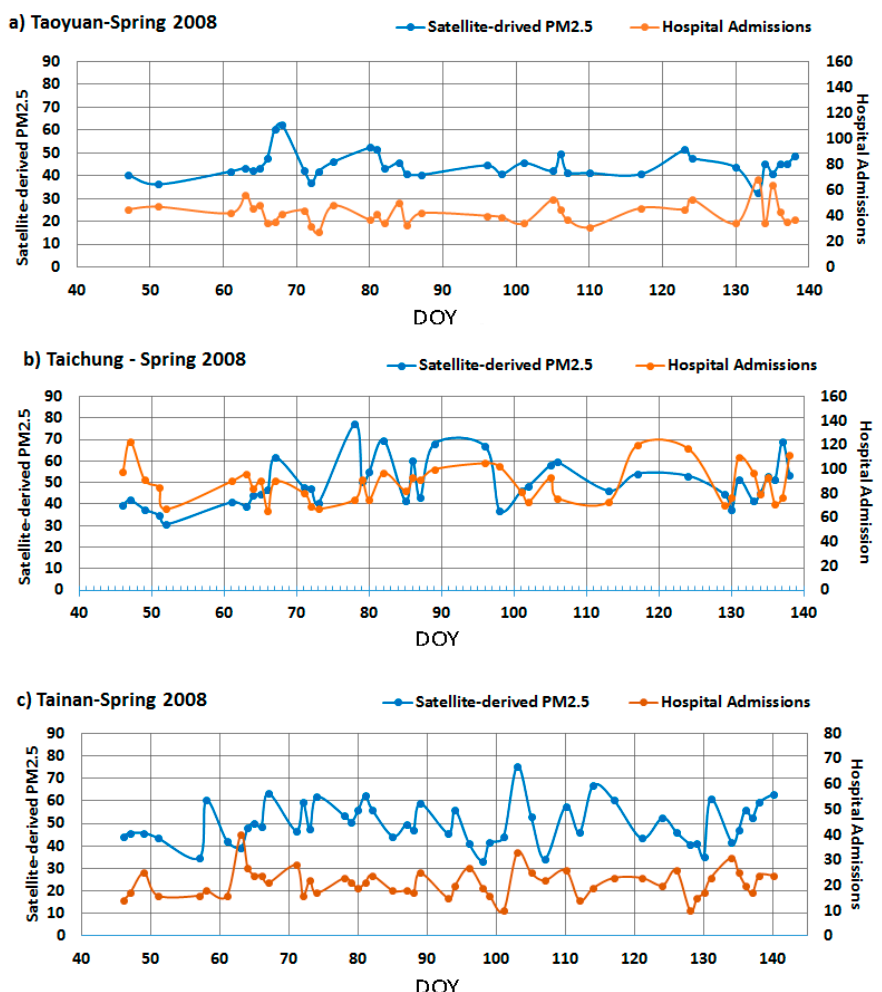
Figure 3. Time-series curves of satellite-derived PM 2.5 levels (blue curves) and hospital admissions for allergic rhinitis (orange curves) in Julian day from 40 to 145 of the year 2008 for Taoyuan ( a ), Taichung ( b ), and Tainan ( c ).